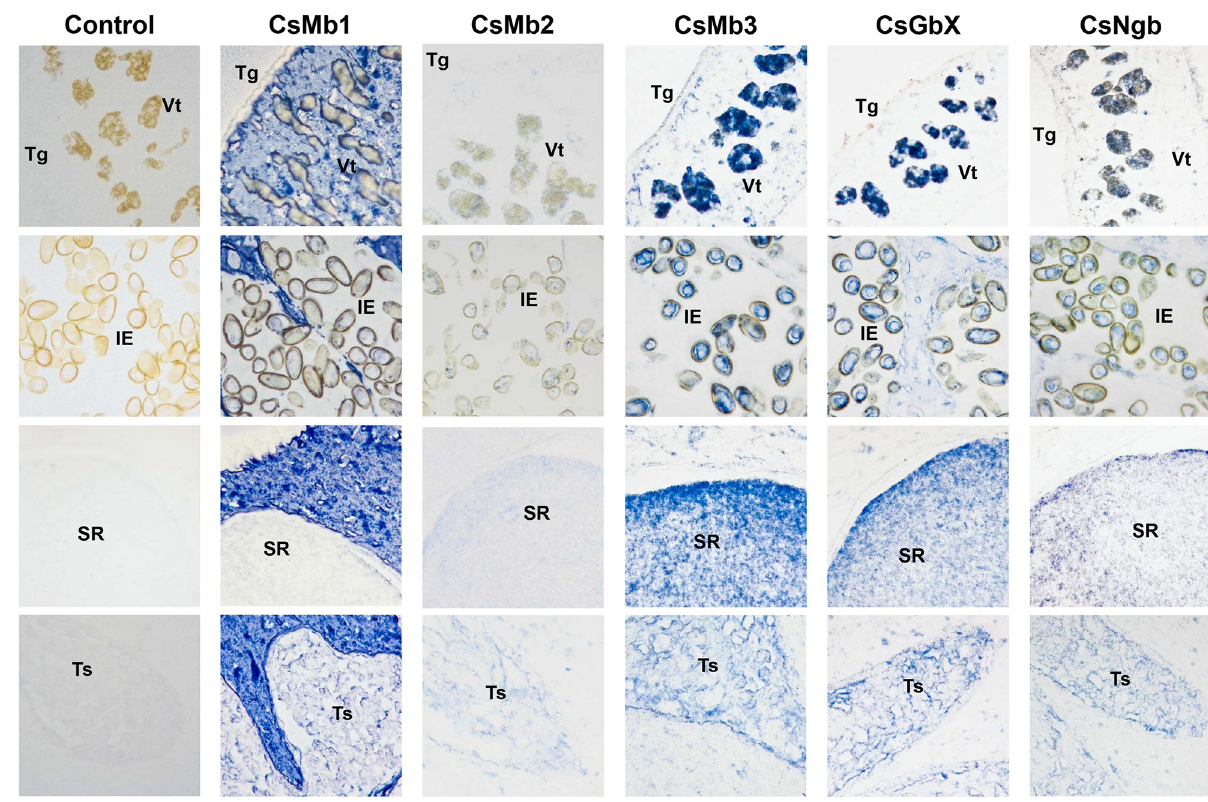
Fig 8. Histological distribution patterns of globins in Clonorchis sinensis adults. The worm sections were incubated with respective mouse antibodies specific to the C . sinensis globins or a pooled pre-immune mouse serum (n = 3) and then a goat anti-mouse IgG antibody conjugated with horseradish peroxidase (HRP). The specific antigen-antibody reactions were developed into a blue color with a blue chromogen for HRP. IE, intrauterine eggs; SR, seminal receptacle; Tg, tegument; Ts, testis; Vt, vitellaria. Original magnifications, x 200.